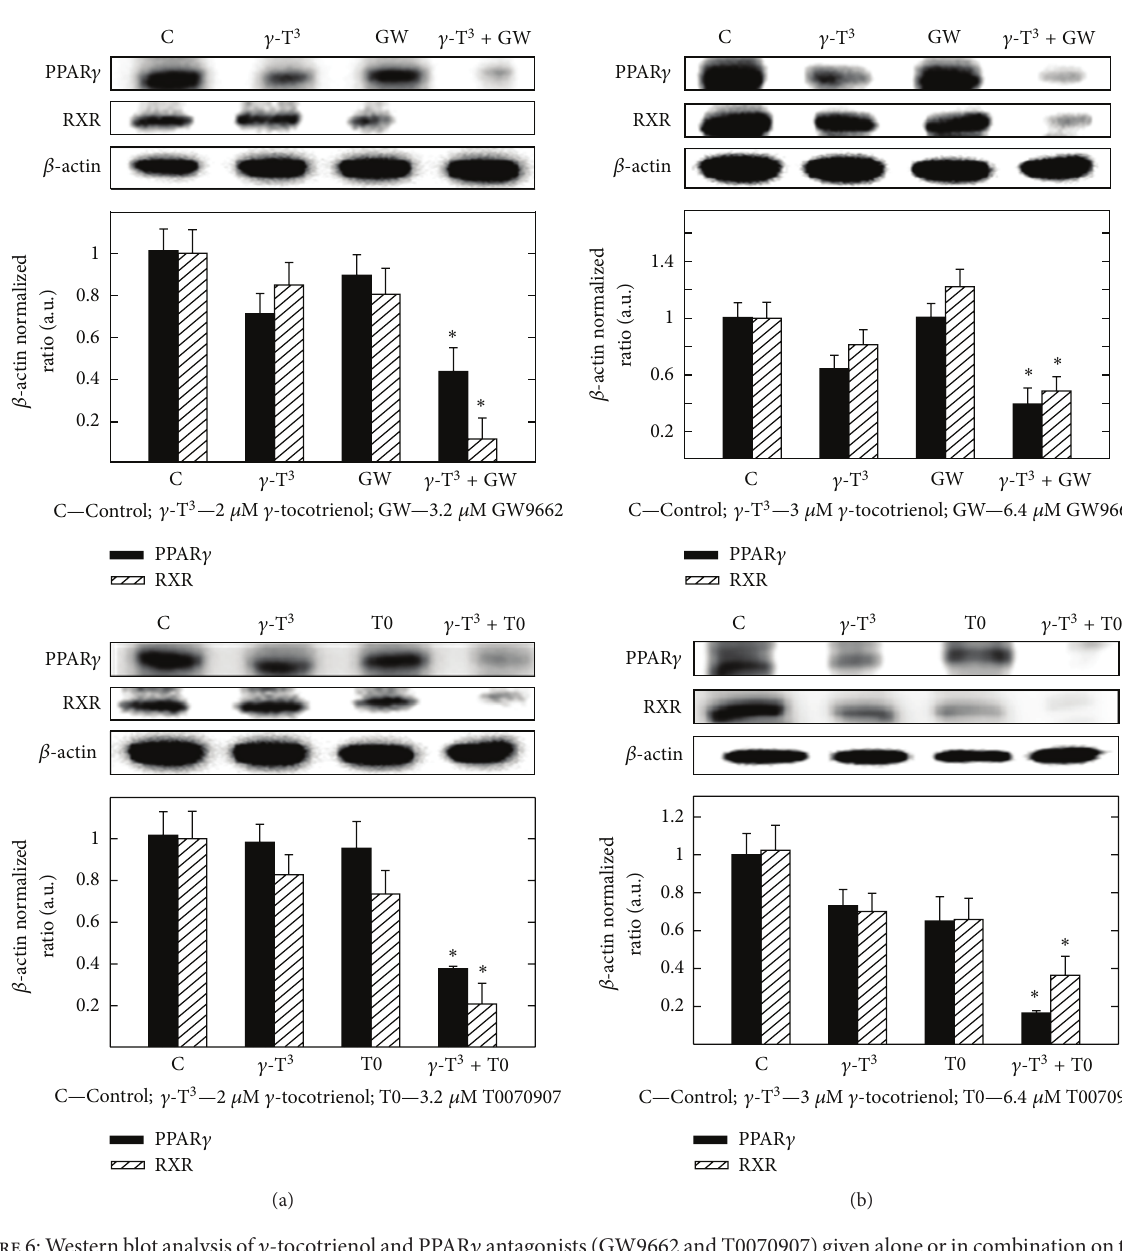
F 6: Western blot analysis of